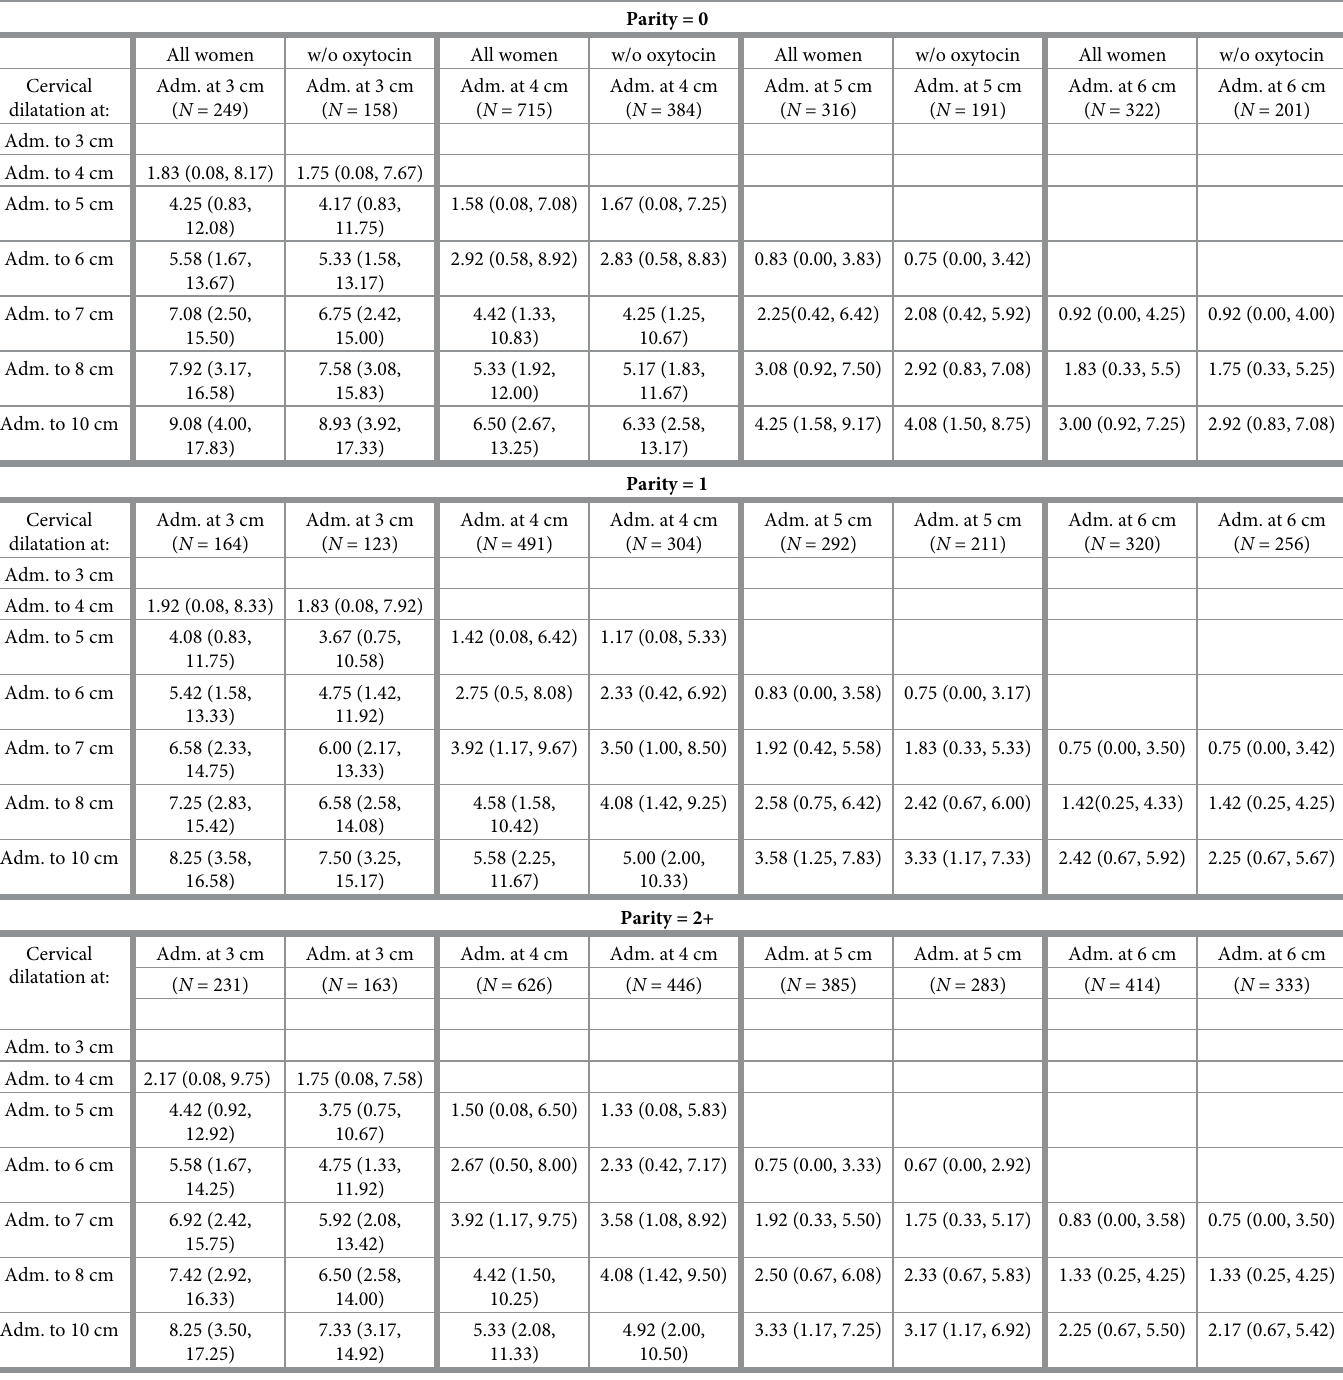
Table 6. Cumulative duration of labour in Para 0, 1, and 2+ based on the cervical dilatation at admission by use of oxytocin augmentation (Markov analysis). Parity =